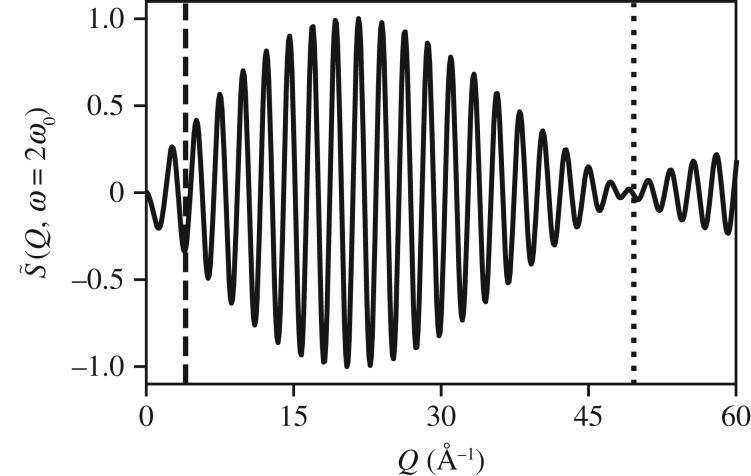
S~(Q,ω=2ω0) generated from ψ1(R)ψ3(R) and scaled relative to figure 10. Below 4 Å−1 (dashed line), the 2ω0 signal is no more than 25% of the scattering signal, but is clearly impacted by the amplitude of motion due to a π phase shift relative to the ω0 signal in figure 10. The node (dotted line) is at 3π/A for this state.